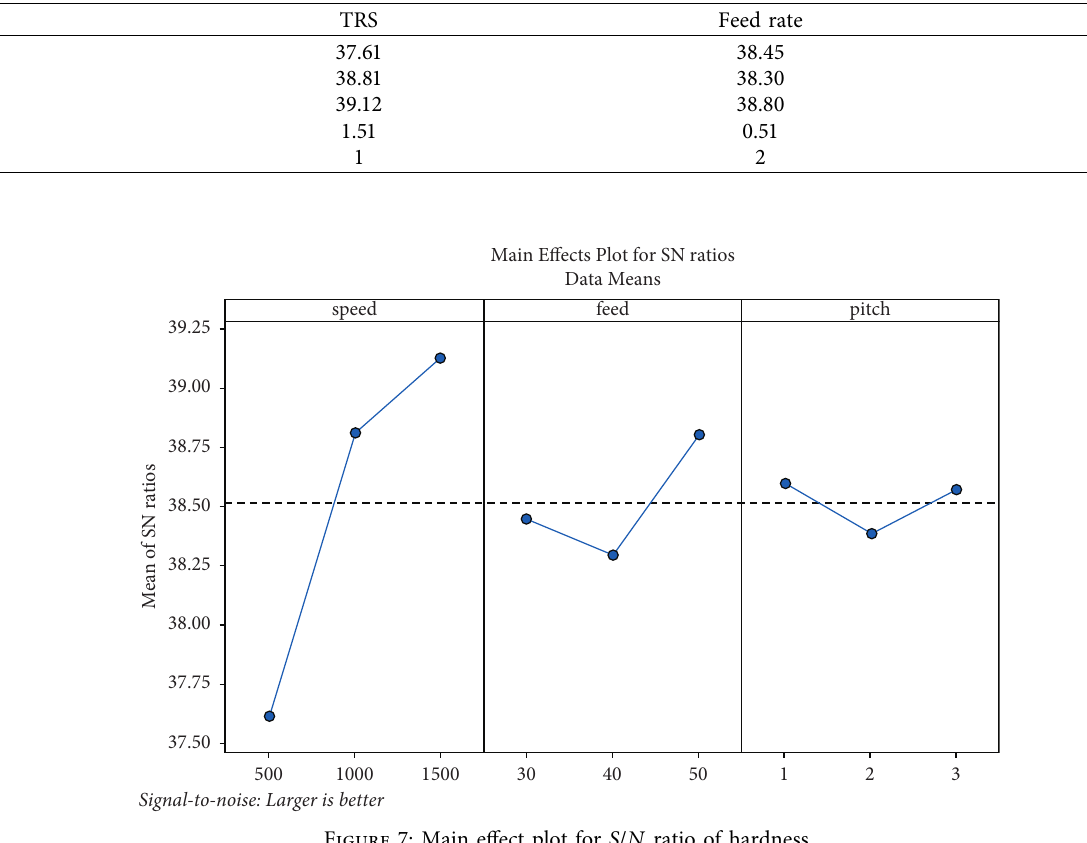
Figure 6: Main effect plot for S / N ratio of UTS. Table 7: Response for S / N ratios of hardness.